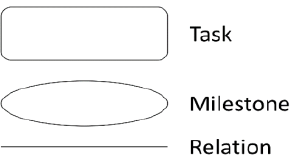
Figure 3. Notation for the case description during the